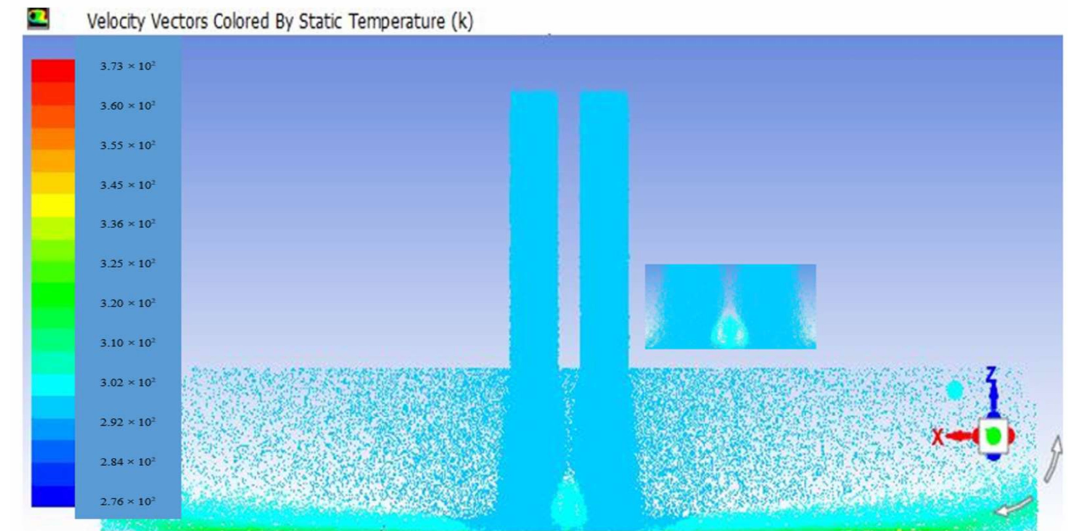
Figure 16. Velocity vectors colored by the static temperature of the twin impingement jet mechanism at the Nozzle-Nozzle spacing equal to 1 cm and the Nozzle-Plate distance equal to 6 cm.